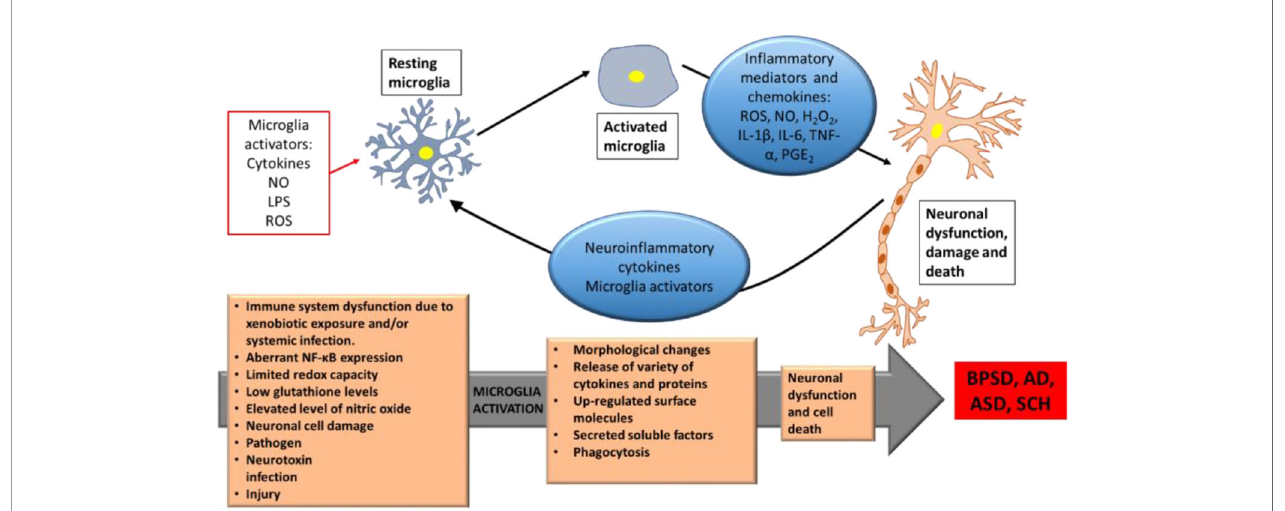
FIGURE 1 | Schematic depiction of microglia activation neuronal cell death in BPSD, AD, ASD, and SCH. Neuroin fl ammatory proteins and cytokines due to microglia activation by genetic and different environmental activators, leading to neuron dysfunctions and cell death. BPSD, Behavioral and Psychological Symptoms of Dementia; AD, Alzheimer ’ s disease; ASD, Autism Spectrum Disorder; SCH, Schizophrenia; NO, Nitric Oxide; LPS, Lipopolysaccharide; ROS, Reactive Oxygen Species; H 2 O 2 , hydrogen peroxide; IL-1 b , Interleukin-1 b ; IL-6, Interleukin-6; TNF- a , tumor necrosis factor- a ; PGE 2 , Prostaglandin E2; NF- k B, Nuclear Factor kappa- light-chain-enhancer of activated B cells. Modi fi ed after (Shabab et al.,